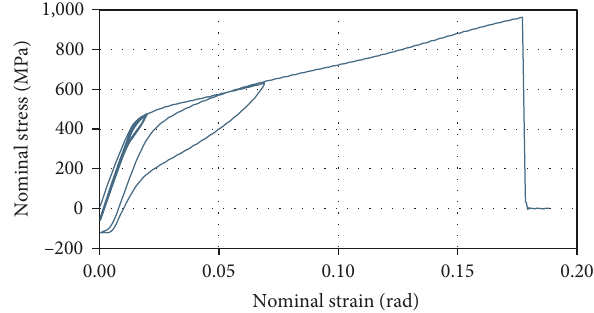
Figure 3: Stress and strain curves for superelastic shape memory alloys (0.033 mm/sec loading speed).